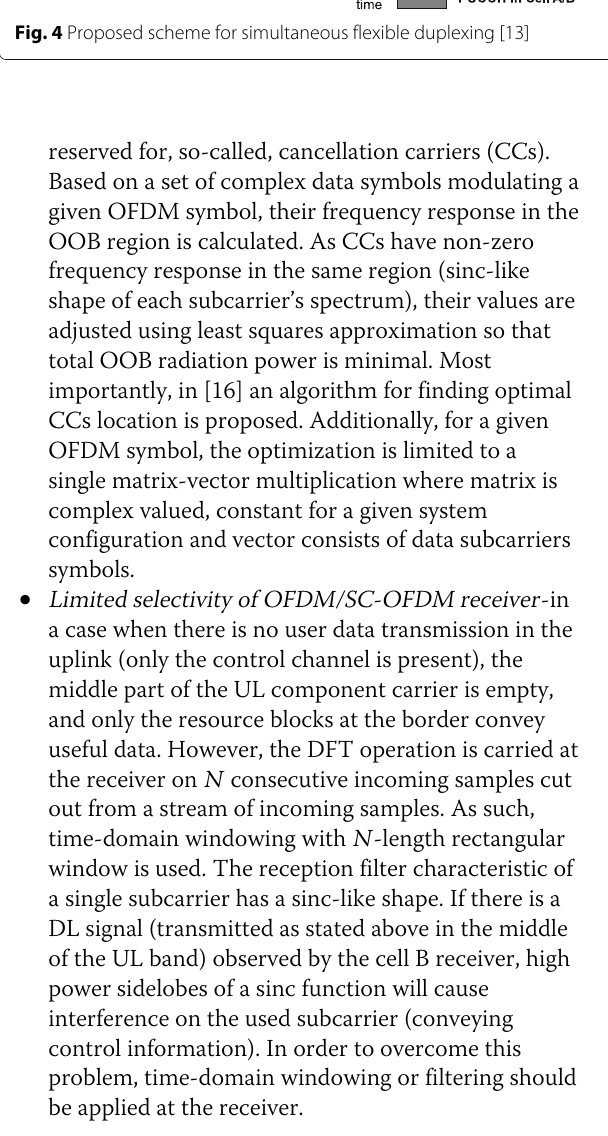
Fig. 4 Proposed scheme for simultaneous flexible duplexing [13]